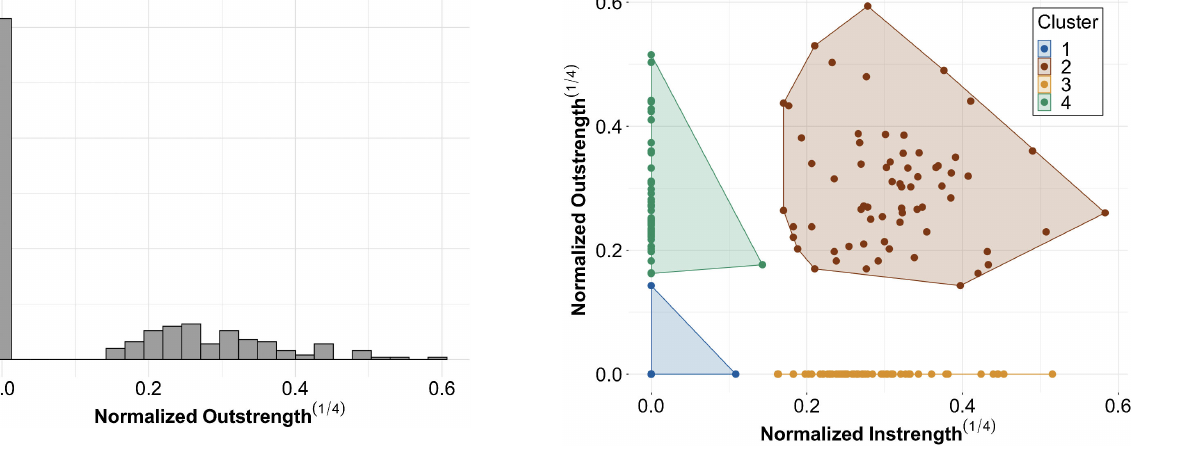
FIG. 10. Cluster plot showing a point for each lab group based on their measures of normalized instrength and normalized outstrength. Point colors indicate the cluster to which the group was assigned using the k -means clustering